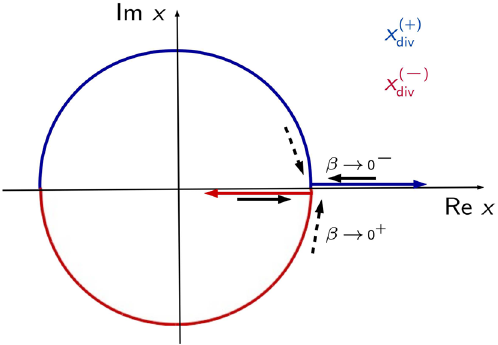
Fig. 2 The position of the singularities of the unexpanded dual prop- agator in terms of the threshold parameter β = 1 − p 2 ( change of variable | q i | = m i / 2 ( x i − x − 1